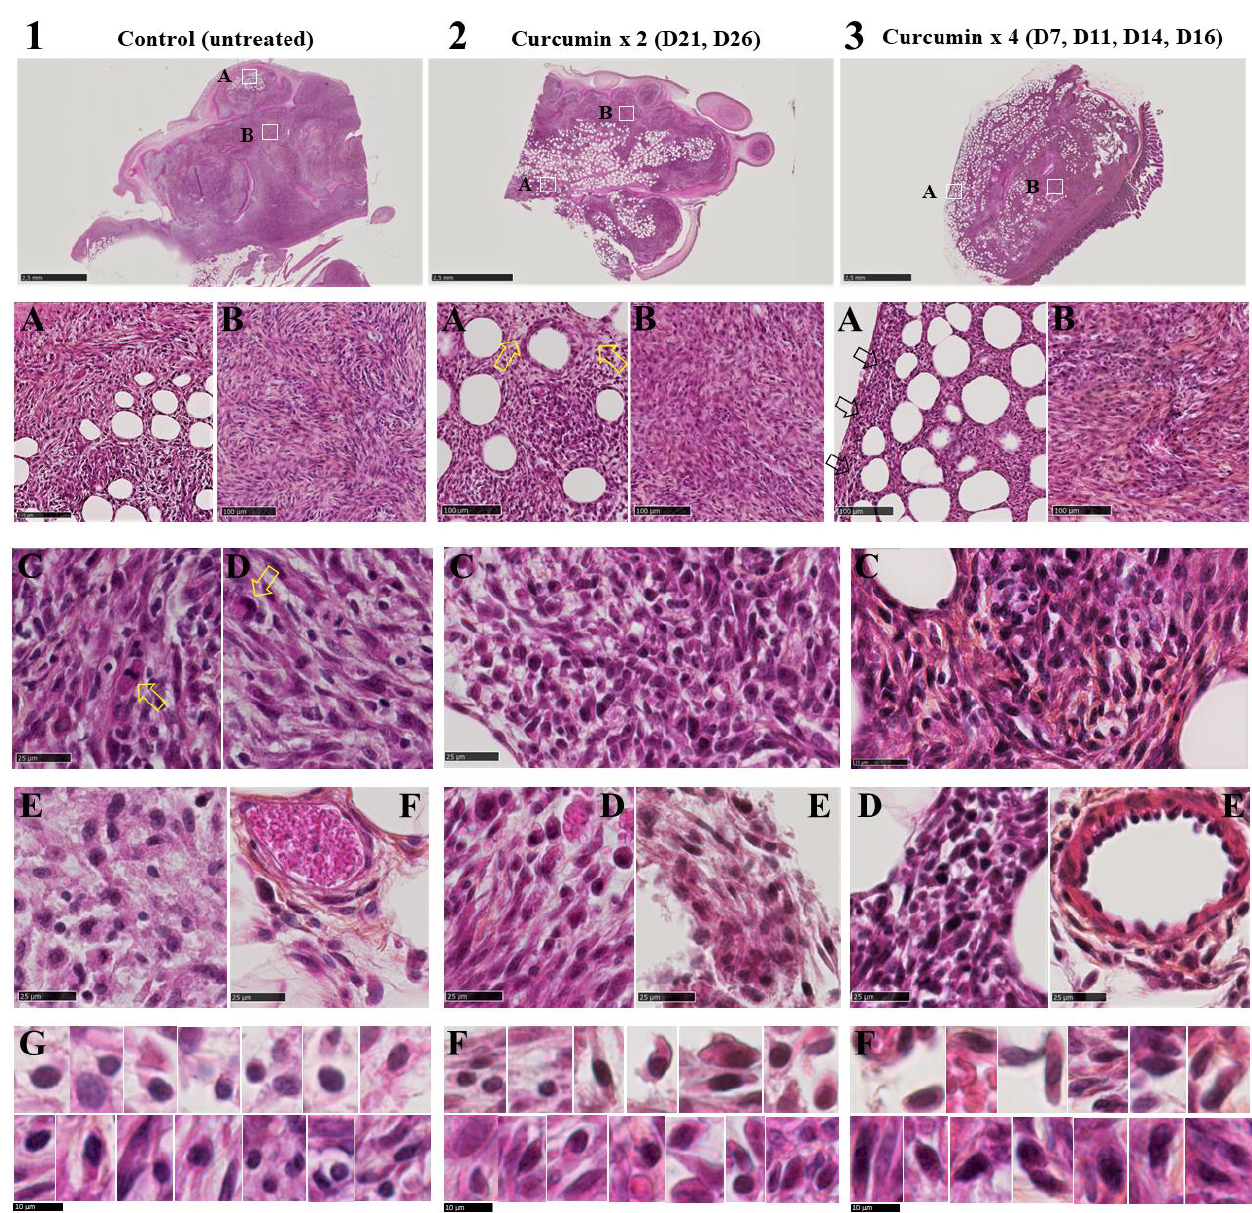
Figure 1. Tumor histological features of M5-T1 mesothelioma tumors. Top, first row : general views of representative tumors from the three groups of rats used for proteomic analysis. HPS staining rendering nuclei, cytoplasm and collagen, respectively, blue-violet, pink and yellow orange. The scale bars represent 2.5 mm. ( Second row , A , B ): magnifications of areas delimited by the white squares shown on general views. The scale bars represent 100 µm. Photograph ( 2A ) shows a decrease in cancer cell density (open yellow arrows) in areas exhibiting necrosis produced by two successive injections of curcumin on days 21 and 26 after tumor challenge. Photograph ( 2B ) illustrates morphological changes of cancer cells which contrasted with the typical sarcomatoid morphology observed in both external and internal views of the tumors from control (untreated) rats ( 1A,B ). Photograph ( 3A ) shows massive infiltration of this residual tumor by lymphocytes (open black arrows) after four successive injections of curcumin on days 7, 11, 14 and 16 after tumor challenge. The internal part was also characterized by morphological changes of cancer cells (as in 2B ) and important signs of fibrosis ( 3B ). Third row : high magnification views of each tumor type (the scale bars represent 25 µm) showing the presence of many mitotic figures ( 1C ) and isolated large macrophages ( 1D ) (open yellow arrows) close to cancer cells exhibiting sarcomatoid